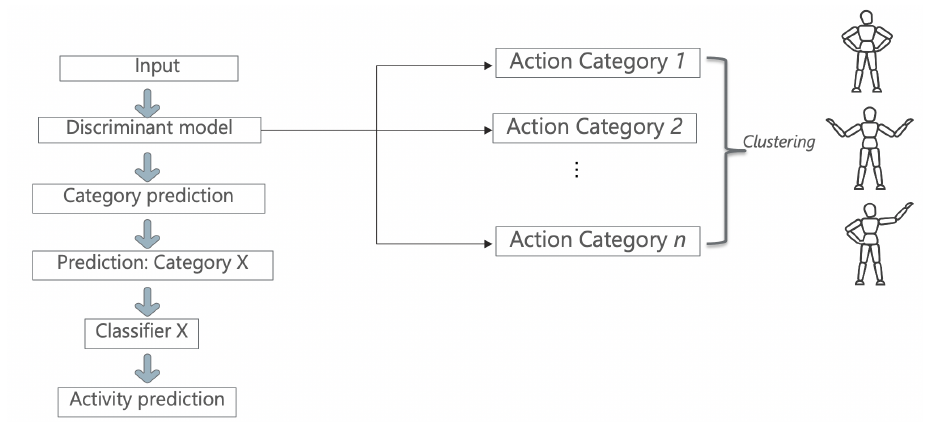
Figure 2. General structure of the proposed